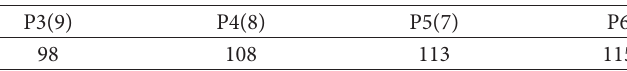
Figure 17: Layout of antislide piles (mm). Table 4: Pile length (cm).